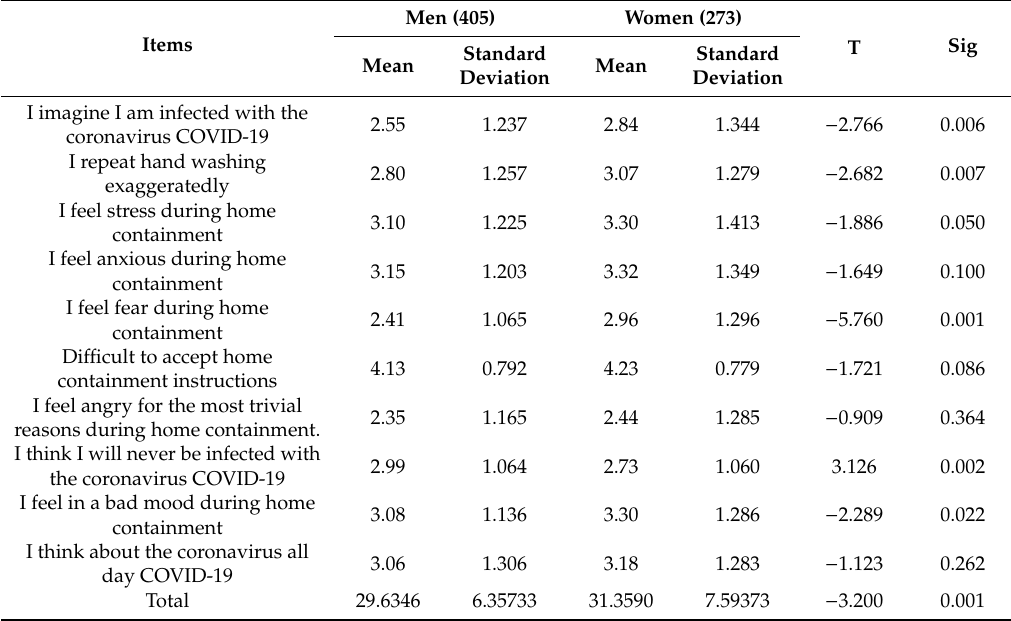
Table 7. The di ff erent psychological impacts of the coronavirus COVID-19 between men and women in Algeria during the first containment of the epidemic ( n = 678). Men